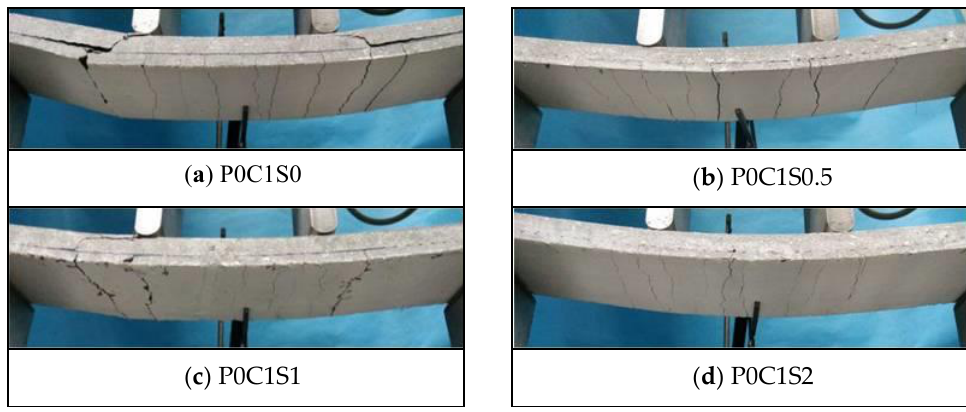
Figure 16. Crack patterns of the TRC specimens with different volume contents of steel fibres.